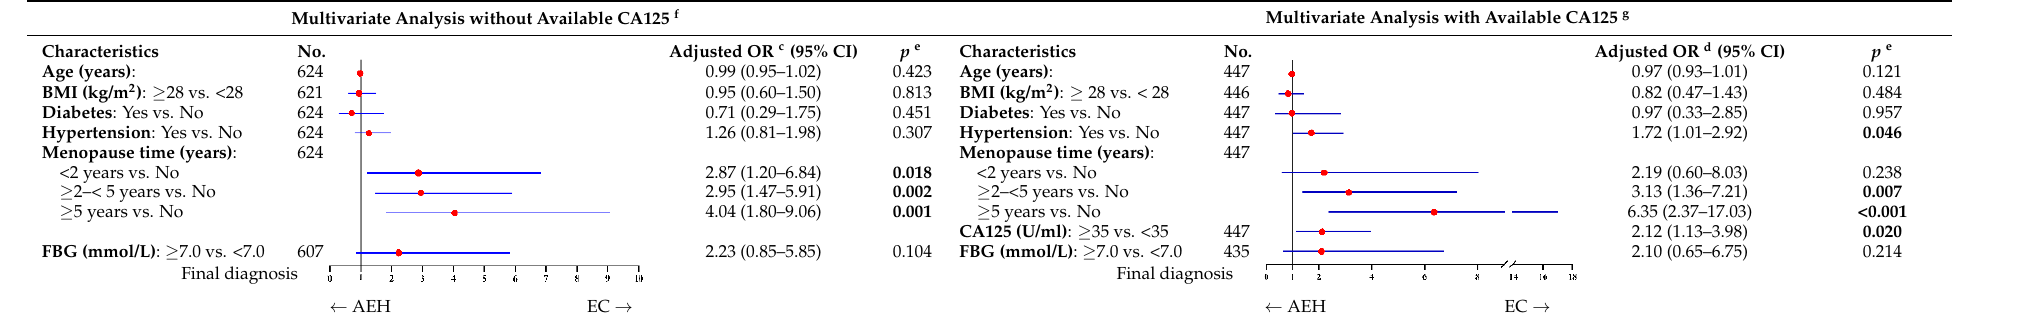
a In total of 190 patients with available data. b In total of 130 patients who had serum CA125 value with available data. c OR adjusted for age, BMI, diabetes, hypertension, menopausal status and FBG level. d OR adjusted for age, diabetes, hypertension, menopausal status and FBG level. e Significant difference p < 0.05. Notes: f CA125 was not included into this analysis for only 130 of 190 final-EC patients had available serum CA125 value. g This analysis was performed in 130 of 190 final-EC patients with available serum CA125 value. Abbreviations: EC, endometrial cancer; final-EC, endometrial cancer diagnosed by final histopathology; OR, odds ratio; CI, confidence interval; BMI, body mass index; CA125, cancer antigen 125; FBG, fasting blood glucose; HOMA-IR, homeostasis model assess- ment—insulin resistance; D&C, dilatation and curettage; HSC, hysteroscopy. Low-risk EC postoperatively was defined as: endometrioid endometrial cancer grade 1–2, myometrial invasion < 50% and no other risk factors presented (which included grade 3, non-endometrioid endometrial cancer, myometrial invasion ≥ 50%, cervical stromal involvement, extra-uterine involvement or lymph-vascular space invasion). All other endometrial cancer cases were defined as interme- diate-high-risk EC. Table 4. Multivariate logistic analysis models on the correlation between menopausal statuses (premenopausal status, postmenopausal time <2 years, ≥ 2–<5 years and ≥ 5 years) and concurrent EC in final histopathology for 624 preoperative-AEH patients a and 447 preoperative-AEH patients b with available serum CA125 value. Multivariate Analysis without Available CA125 f Multivariate Analysis with Available CA125 g Characteristics